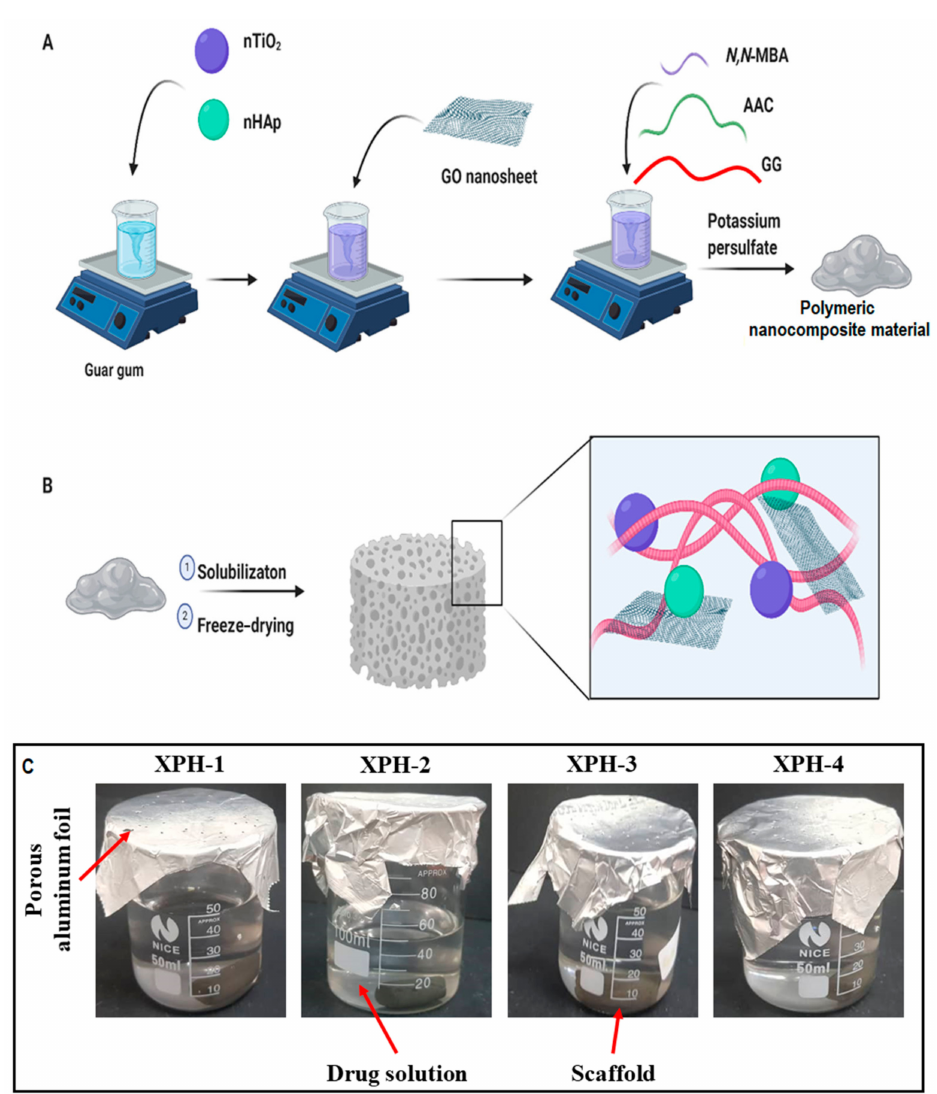
Figure 1. ( A ) Synthesis of polymeric matrix of nanocomposite through free radical polymerization. ( B ) Fabrication of porous scaffold via freeze-drying technique. ( C ) Silver sulfadiazine drug was loaded by a simple dip and dry